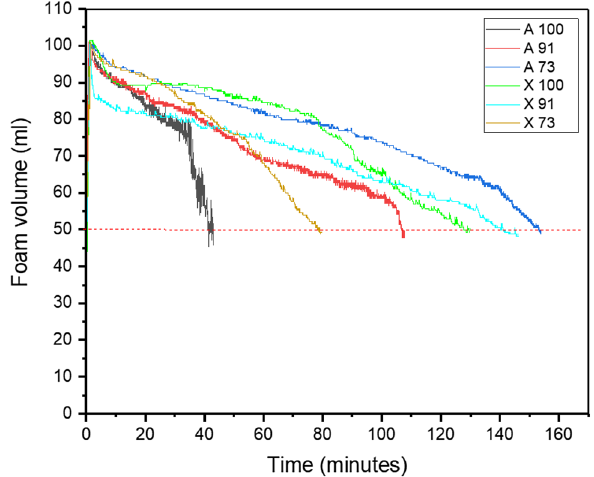
Fig. 5 Foam decay profile of different surfactant solutions with and without the foam booster (LB) at 60